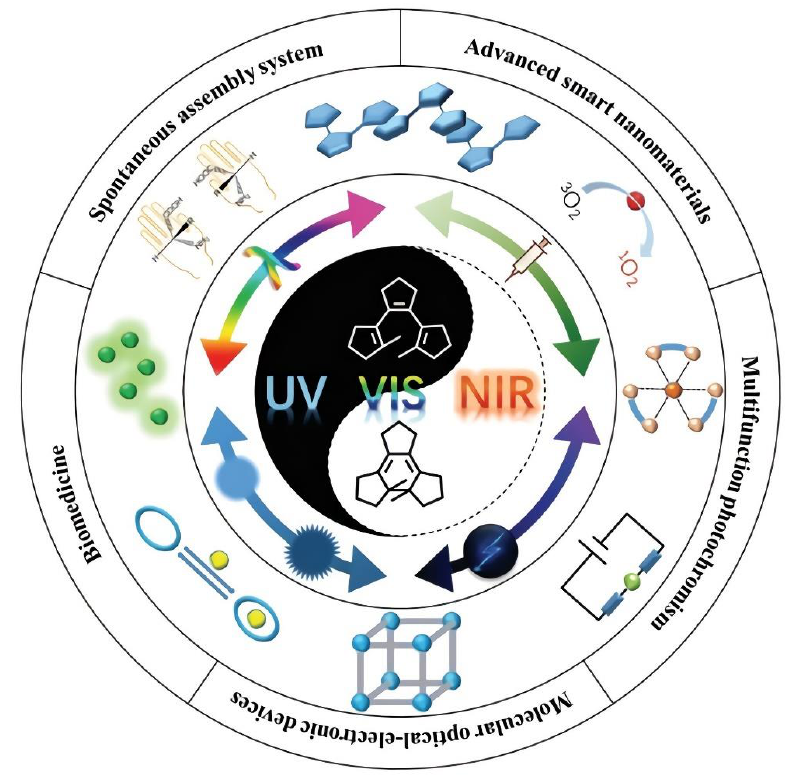
Figure 4. Diarylethene: a stimulus-responsive functional molecular switch. Reproduced with the permission of Wiley-VCH GmbH from [148]. Copyright 2022, John Wiley & Sons.